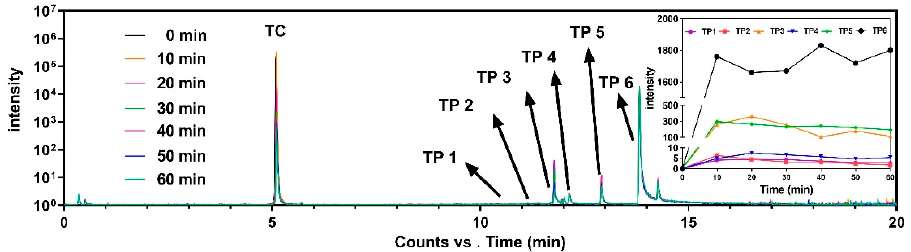
Figure 8. The overlapped total ion chromatogram for the experimental time for the intensity development of TC and its transformation products eluted at different retention times. The detailed intensity development for six transformation products during the experiments is top right.